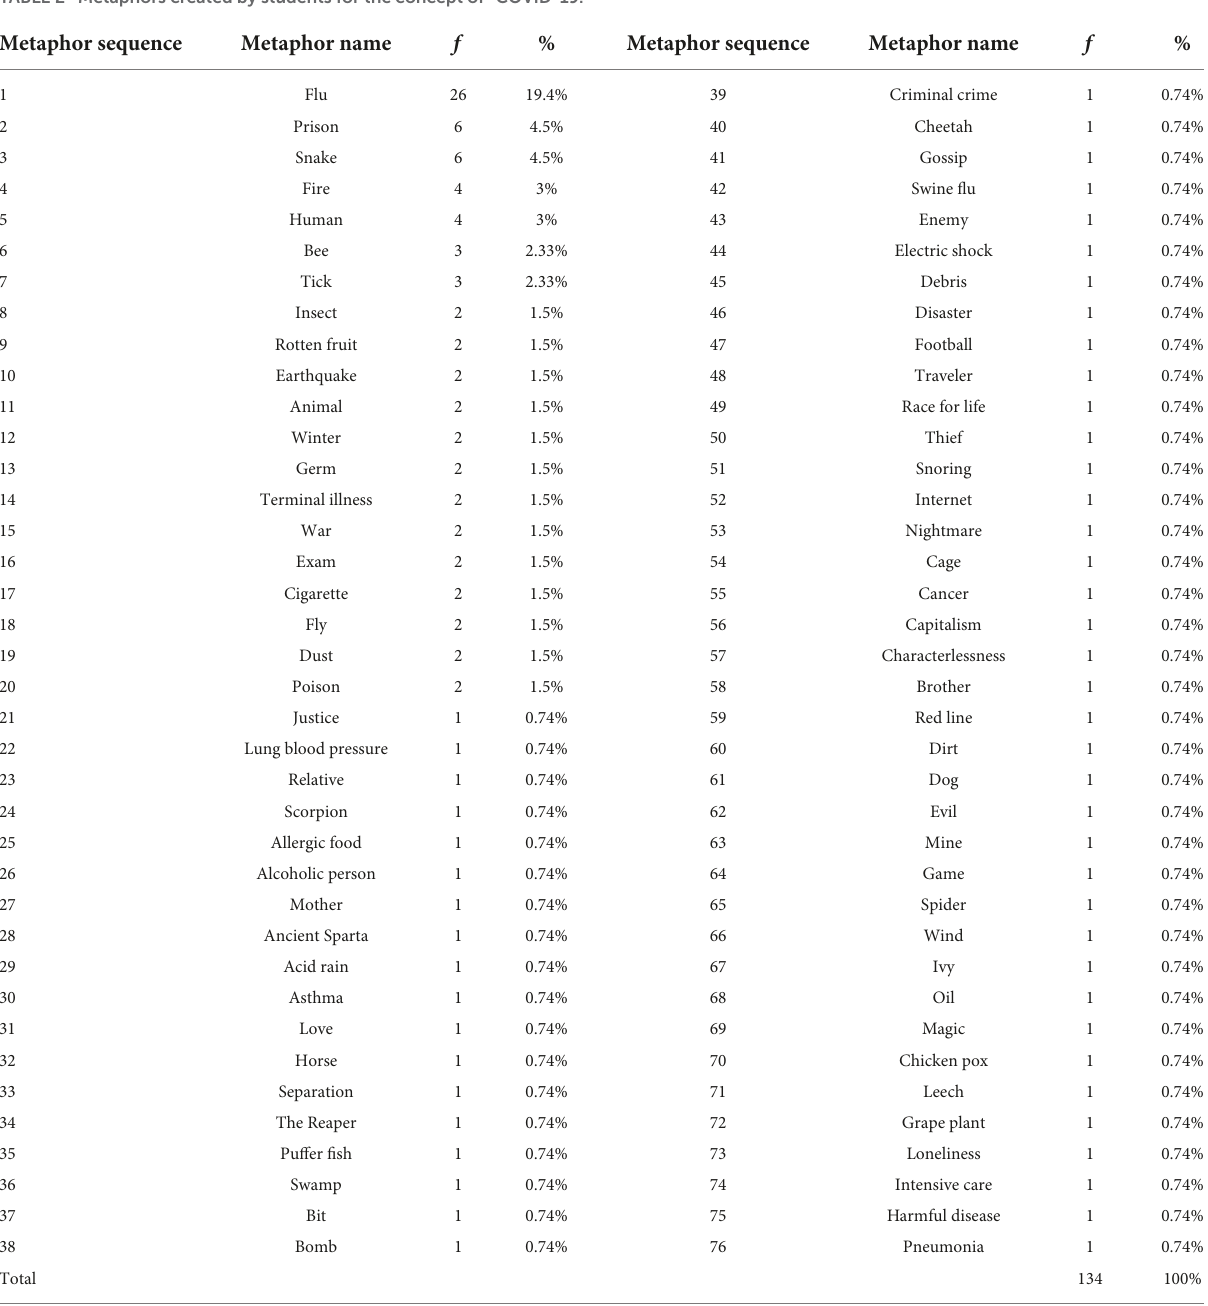
TABLE 2 Metaphors created by students for the concept of